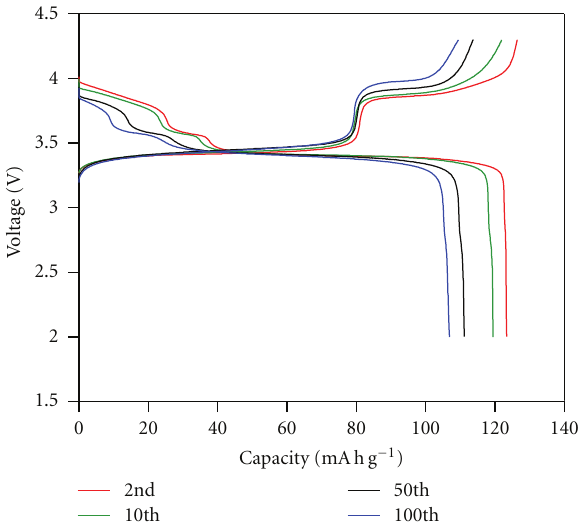
· 3 . 5H ] 2 O against the Li metal at the 2nd, 10th, 50th, and 6 0 . 83